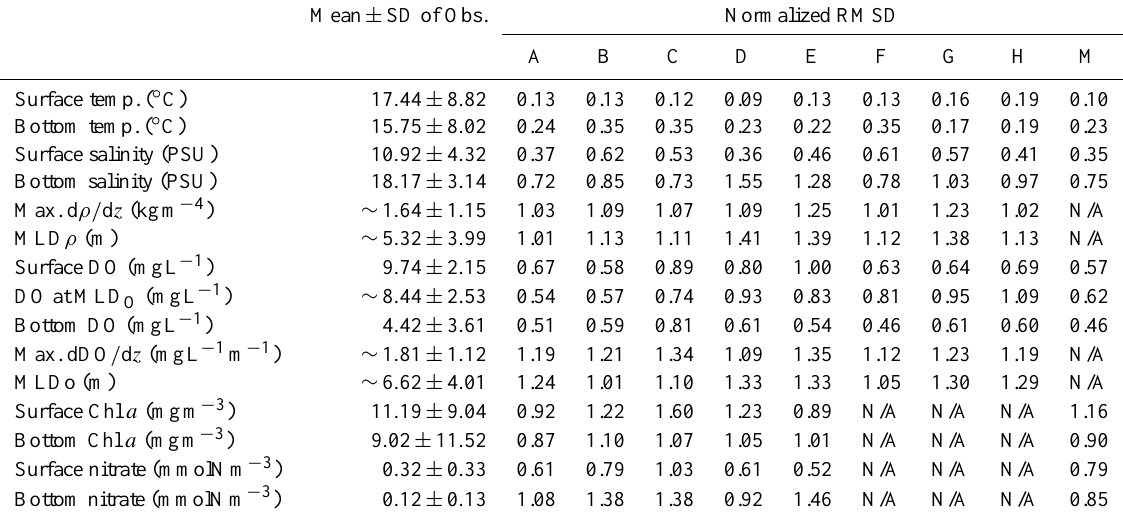
Table 3. Mean and standard deviation (SD) of observations and total normalized RMSD for each model. RMSD for each model except when not applicable (N/A). Mean ± SD of Obs. Normalized